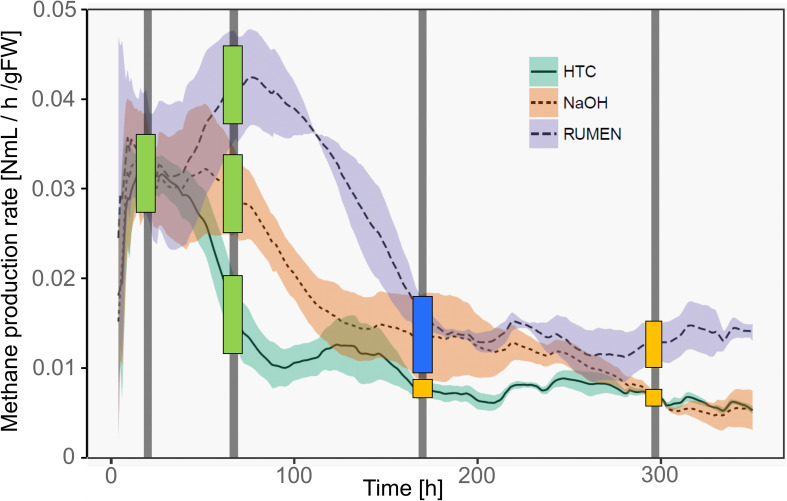
Methane production rates of the three treatments over time. Lines represent mean values, shaded areas the standard deviation (n = 3). Vertical bars mark the time points of sample collection (T1–T4). Colored squares depict the physiological state of the samples taken at these time points. Green, HPP (high productive phase); blue, CL (cell lysis); yellow, LPP (low productive phase).